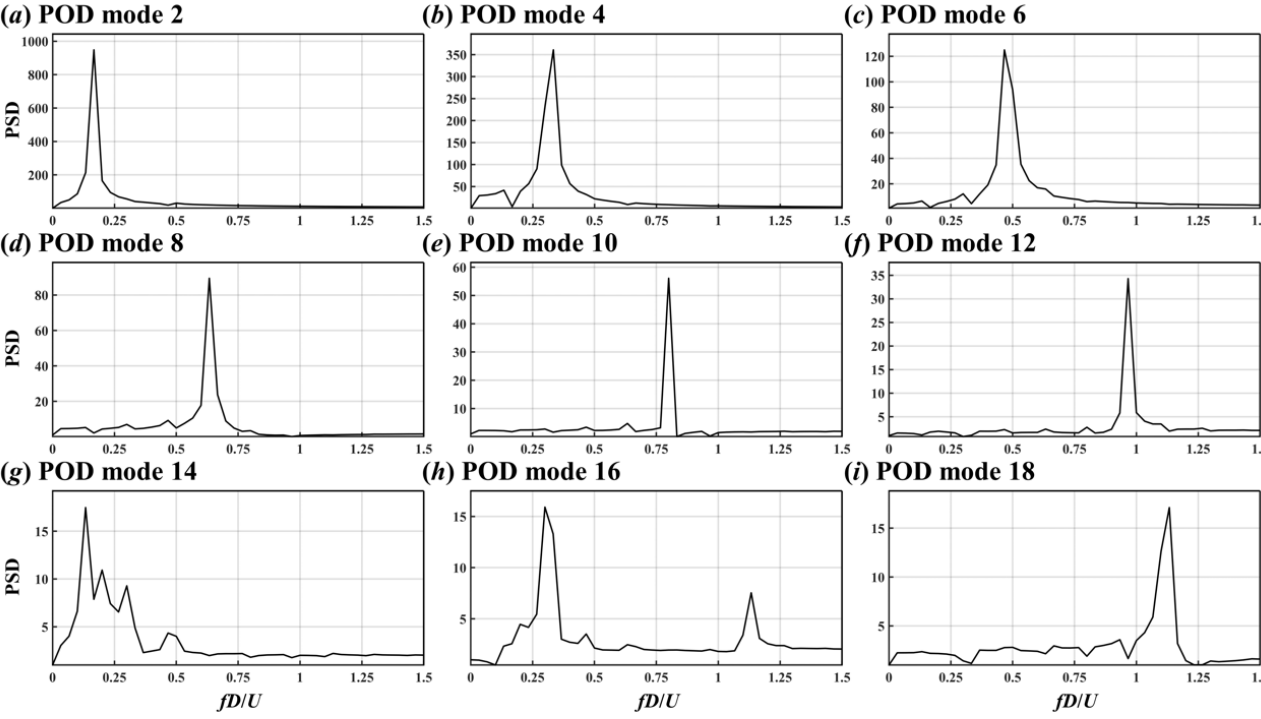
Figure 23. PSDs of the 2nd ( a ), 4th ( b ), 6th ( c ), 8th ( d ), 10th ( e ), 12th ( f ), 14th ( g ), 16th ( h ), and 18th ( i ) POD modes for the flow around the two crossing cylinders in 60° arrangement. For the flow around the UC, it can be seen from the 2nd, 4th, 6th, 8th, 10th, 12th, and 18th POD modes in Figure 20 that the modal patterns in the range of 0.5 < x / D < 4.5 were